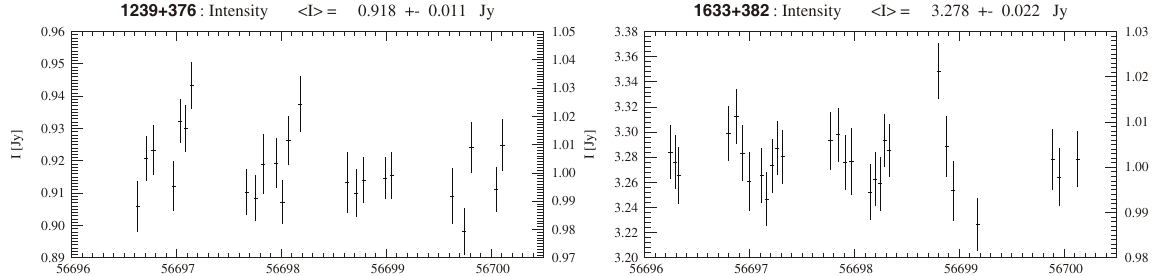
Figure 2. Two example sources with no variability. ( Left panel ) the light curve of B2 1239 + 376 at 4.8 GHz in 8–12 February 2014; ( right panel ) the light curve of 1633 + 382 at 4.8 GHz in 8–12 February